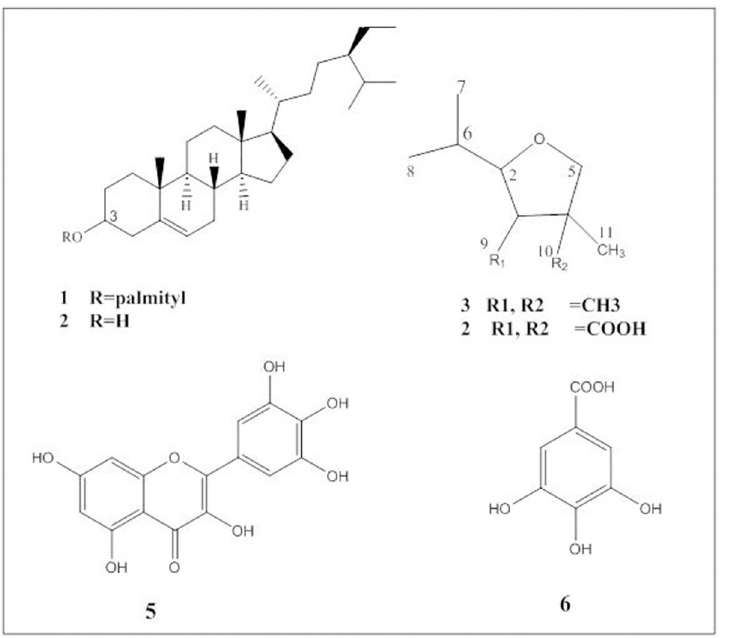
Fig 3. Compounds isolated from the root extract of Limonium axillare